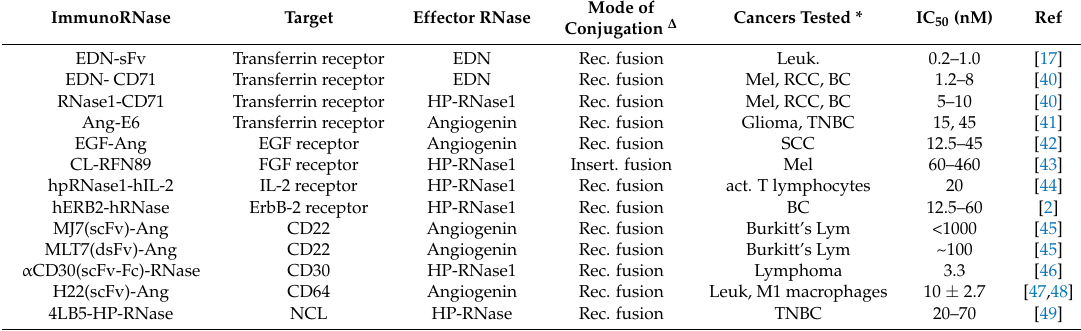
Table 2. Humanized ImmunoRNases as human cytolytic fusion proteins (hCFPs) in preclinical development.